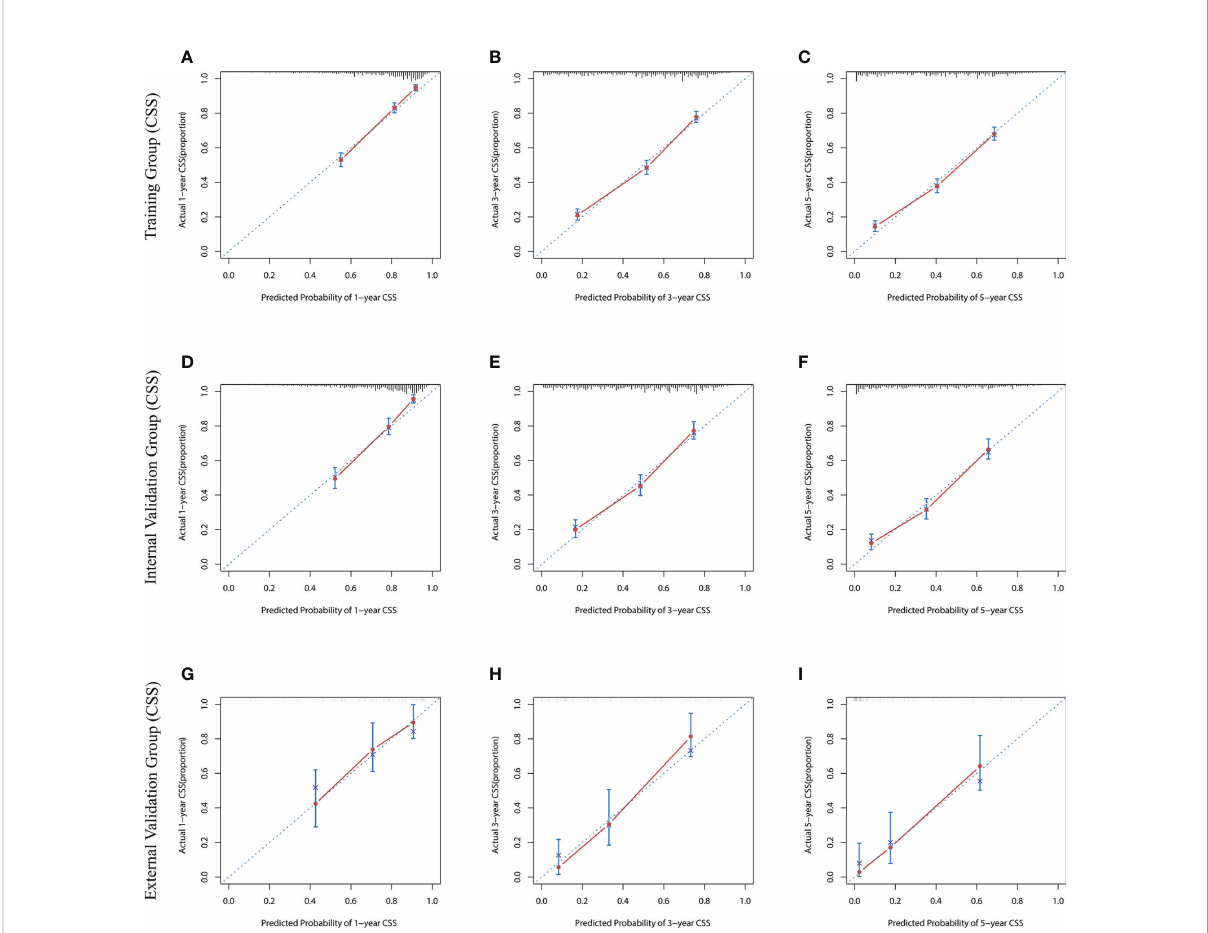
FIGURE 4 The calibration curves for predicting CSS at (A) 1-year and (B) 3-year and (C) 5-year in the training cohort, and at (D) 1-year (E) 3-year and (F) 5- year in the internal validation cohort, and at (G) 1-year (H) 3-year and (I) 5-year in the external validation